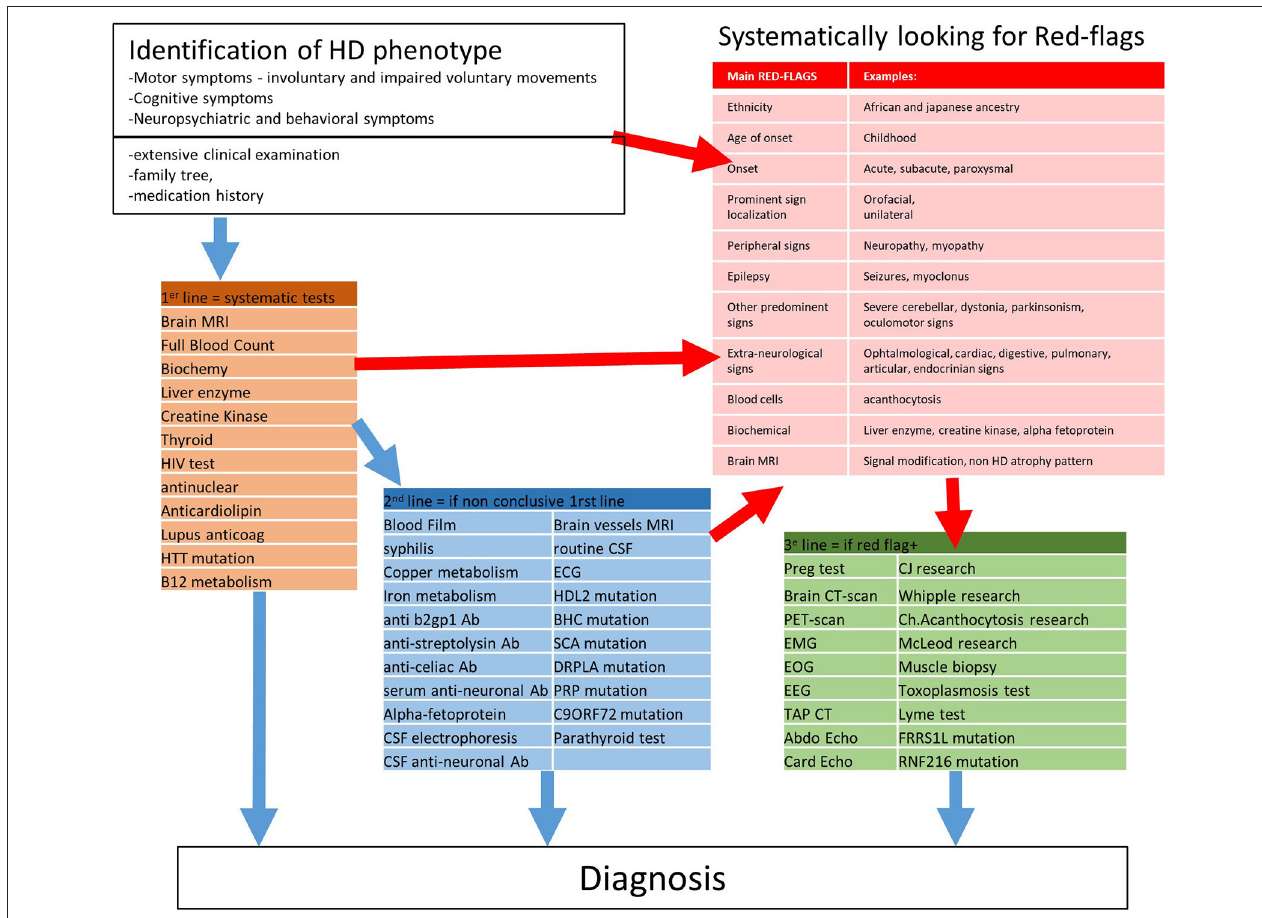
FIGURE 3 | Proposition of a strategy to diagnose HD phenocopy. Ab,